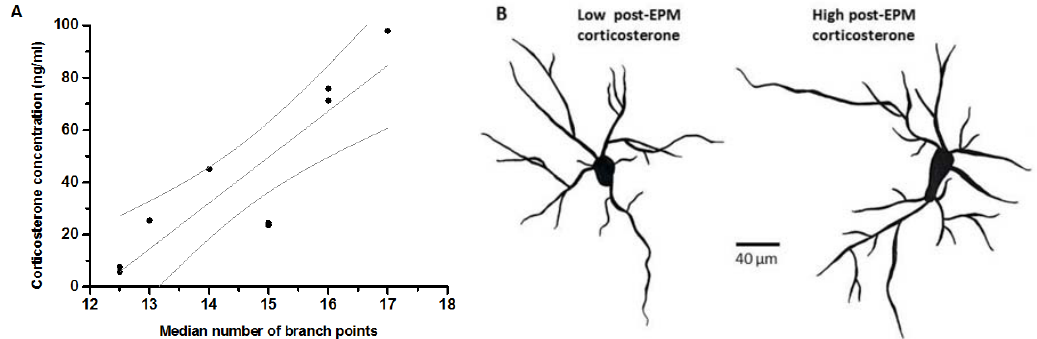
Figure 4. Correlation between branch points and corticosterone concentration. The abscissa of panel ( A ) depicts number of branch points per basolateral amygdala neuron (median from a sample of eight neurons sampled per animal). Ordinate depicts serum corticosterone concentration (ng/mL) thirty minutes after exposure to the elevated plus-maze. Best linear fit is also depicted with 95% confidence interval (R 2 = 0.75, slope = 17.5 ± 3.5; n = 9 animals; grey lines). Panel ( B ) depicts representative BLA neuronal tracings from animals exhibiting low ( left , 5.7 ng/mL) and high ( right , 71.2 ng/mL) corticosterone response post-EPM. Scale bar = 40 µ m.